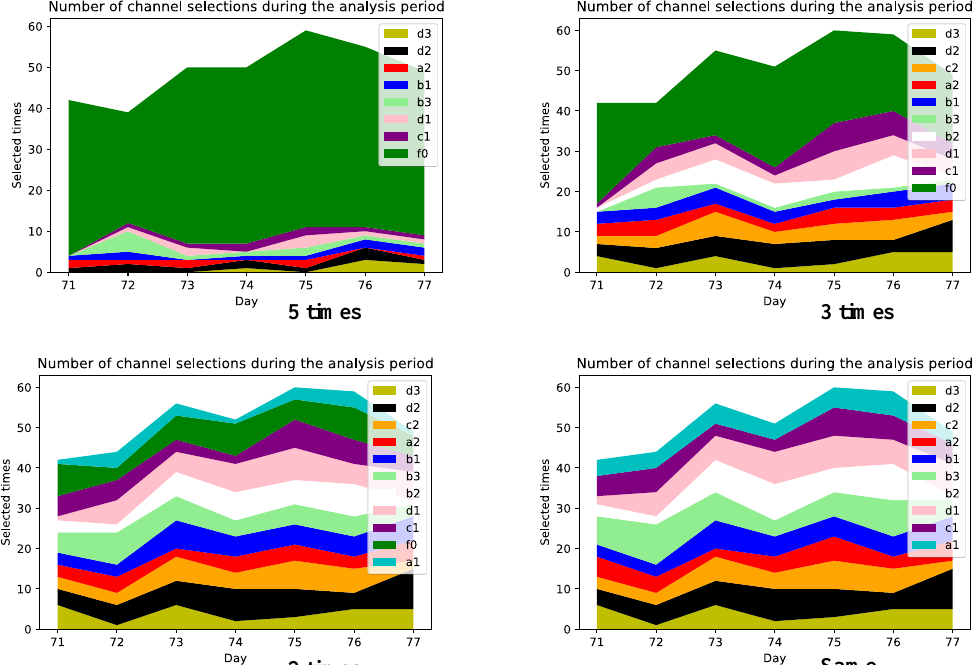
Figure 5. Channel selection under different store service